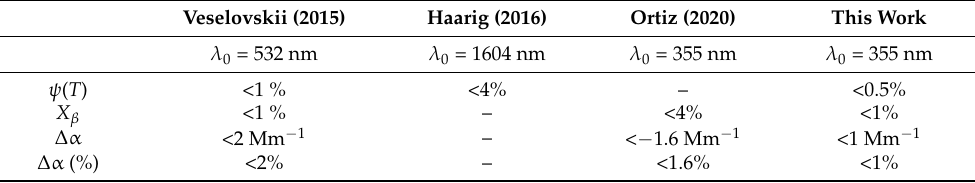
Table 4. Temperature dependence comparison with previous works. Temperature range: 230–300 K. Aerosol load of 100 Mm − 1